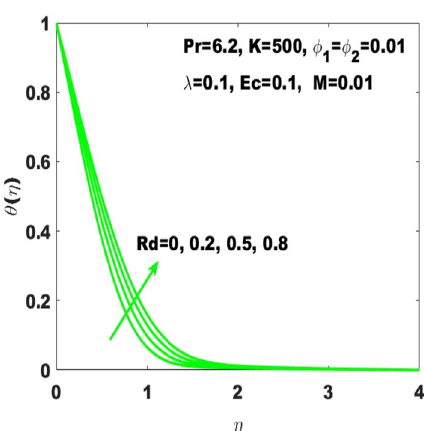
Figure 6. θ ( η ) for diverse values of